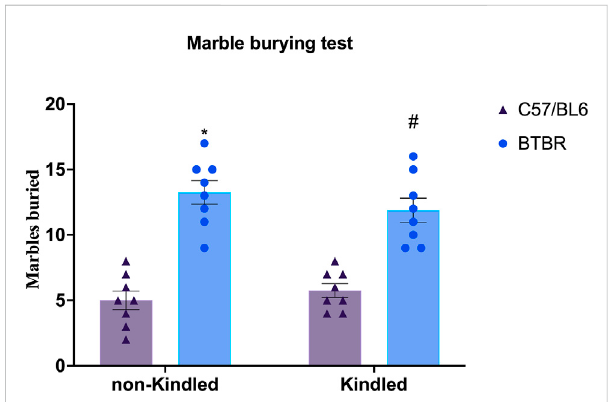
FIGURE 2 Marble burying assay performed at the end of the PTZ-kindling procedure. Bars indicate the number of marbles buried. Data are expressed as means ± S.E.M. *Indicates p < 0.0001 vs. non-kindled B6 mice, # Indicates p < 0.0001 vs. kindled B6 mice. B6 = C57BL/ 6J; PTZ =